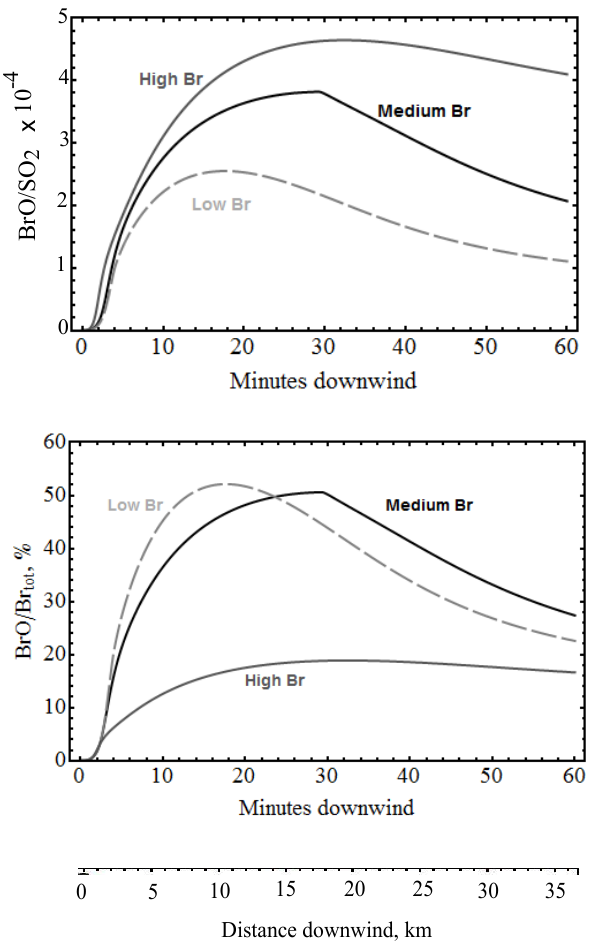
Figure 4. Predicted evolution in BrO/SO 2 (top) and BrO/Br tot ra- tios (bottom) over 1h for the three different bromine emission sce- narios. Model runs correspond to those shown in Fig. 3 assuming V A : V M = 5:95 for the high-temperature